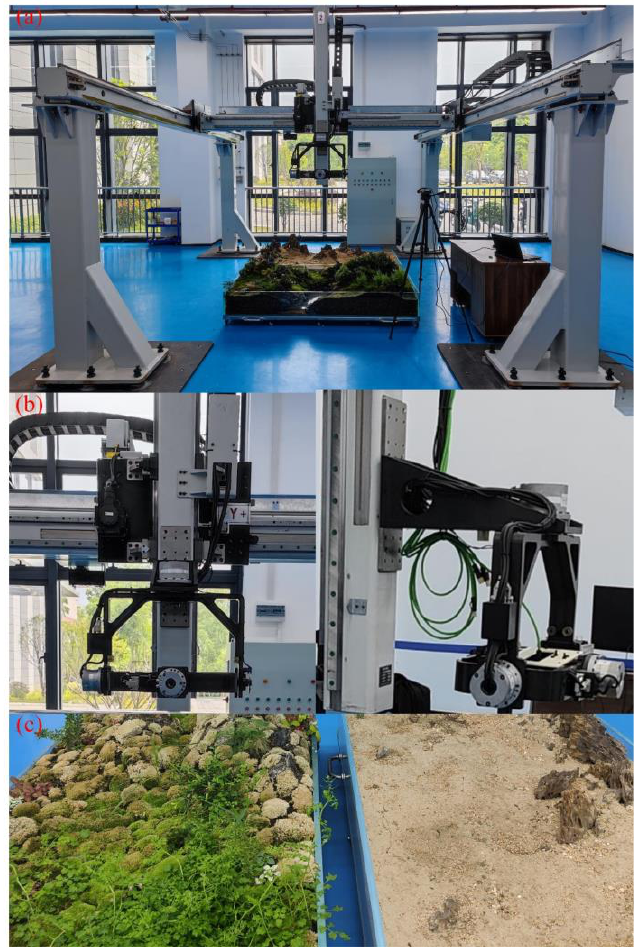
Figure 11. Real system pictures of the simulation system: ( a ) front view, ( b ) rotary table, ( c ) simulation-environment sandbox.